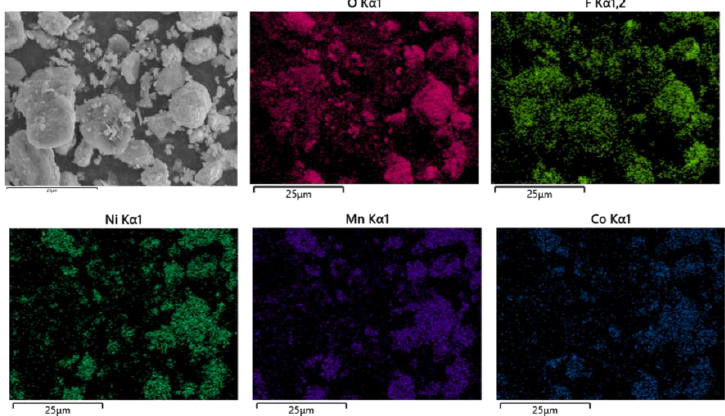
Figure 13. XRD of battery materials after pyrolysis at 200 °C.